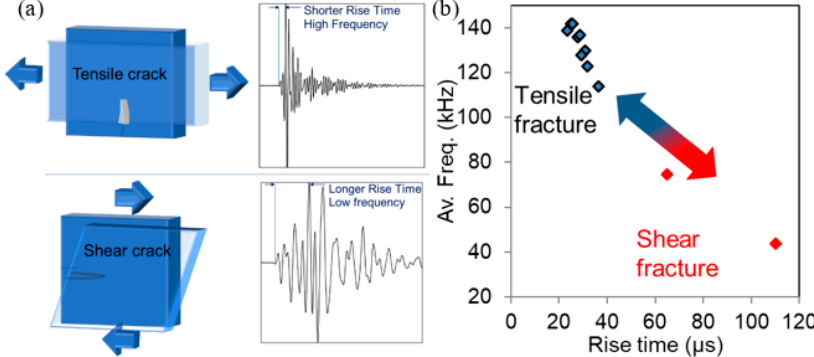
Figure 1. ( a ) Schematic representation of fracture modes and corresponding acoustic emission (AE) waveforms; ( b ) Av. Freq. vs. rise time plot from bending of textile-reinforced cement (TRC) beams taken from [18].